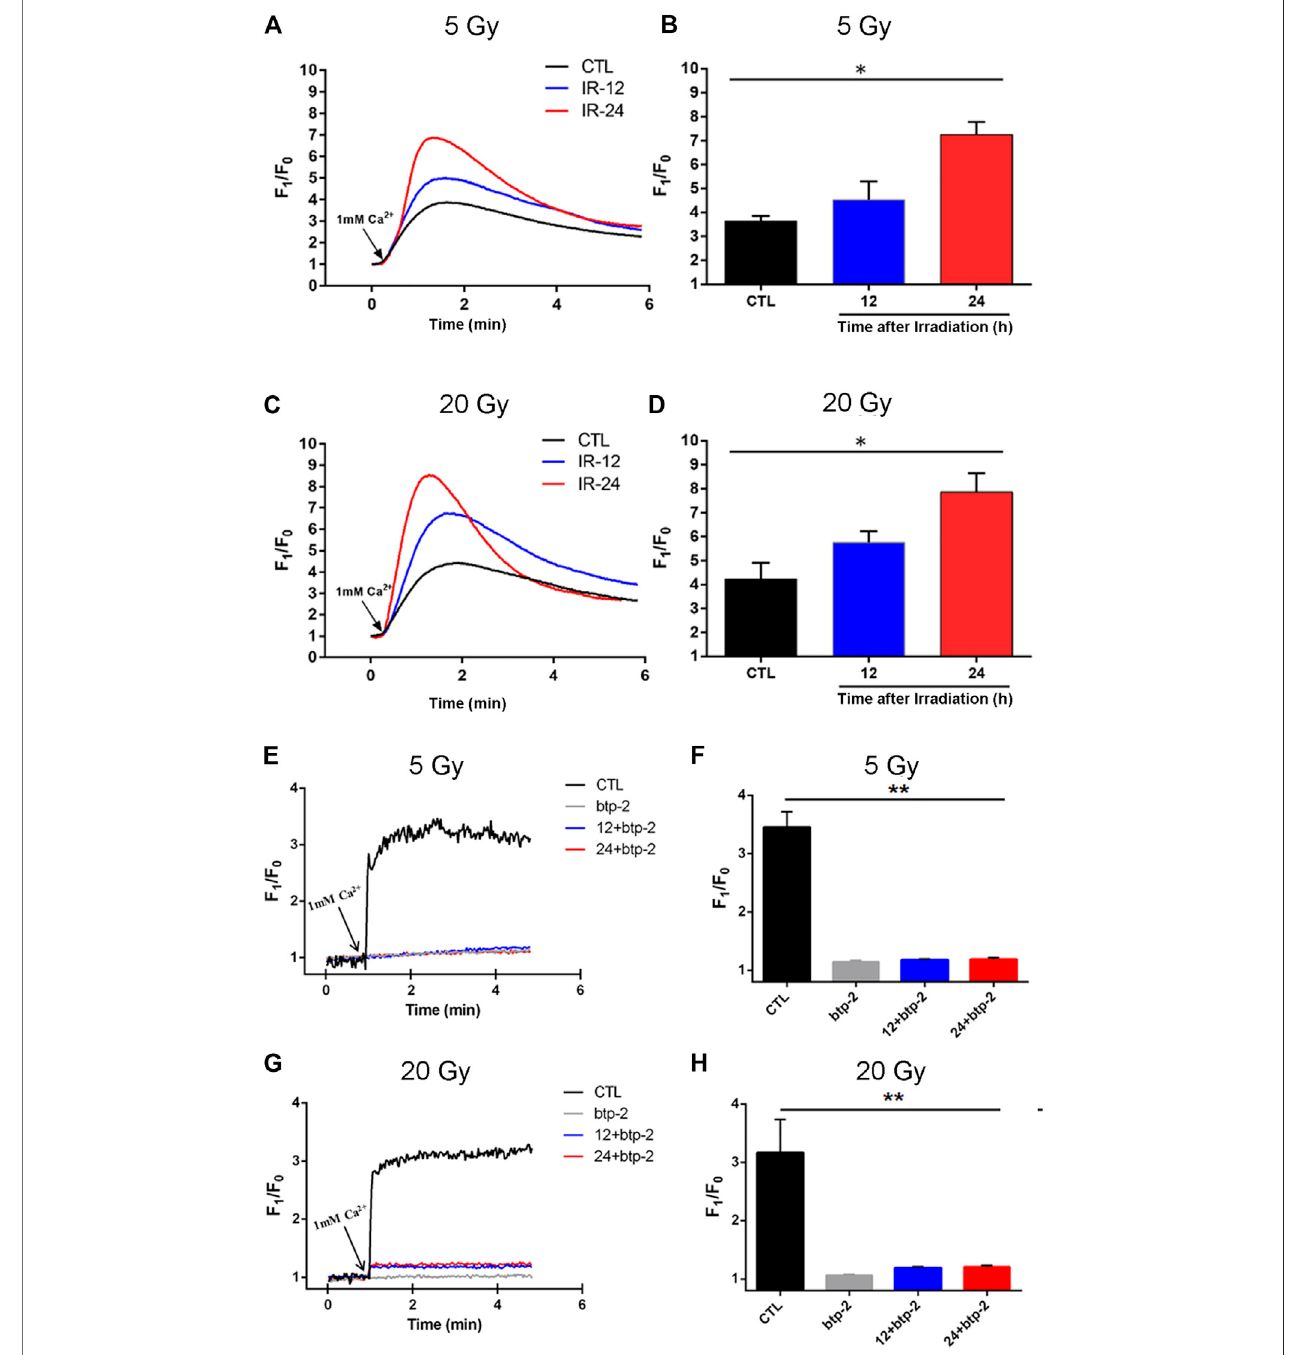
FIGURE6| Effectofx-rayexposureonOrai2 - associatedstore-operatedCa 2+ entry(SOCE)inbrainmicrovascularendothelialcells(BMECs). (A – D) Changesinthe magnitudeofCa 2+ entryviaSOCEintheBMECs.Representativetraces (A,C) andsummarydata (B,D) showingSOCEevokedbytheadditionofthapsigargin(2 µM)in BMECs12 h(IR-12)or24 h(IR-24)after thedeliveryof5 Gy (A,B) or20 Gy(C,D)ofionizingradiationornot(CTL).SOCEwasachievedbyre-introducing1 mMCa 2+ to a Ca 2+ -free bath solution. F 1 /F 0 represents the magnitude of the Ca 2+ in fl ux. (E – H) Orai blocking inhibited the enhancement of store-operated Ca 2+ entry (SOCE) inducedbyx-rayexposureinBMECs.Representativetraces (E,G) andsummarydata (F,H) showingthapsigargin-evokedSOCEinBMECs.10µMbtp-2wasaddedto a Ca 2+ -free bath solution. Data are shown as the mean ± SEM ( n (cid:2) 6). * p < 0.05, ** p < 0.01 vs. the control group.